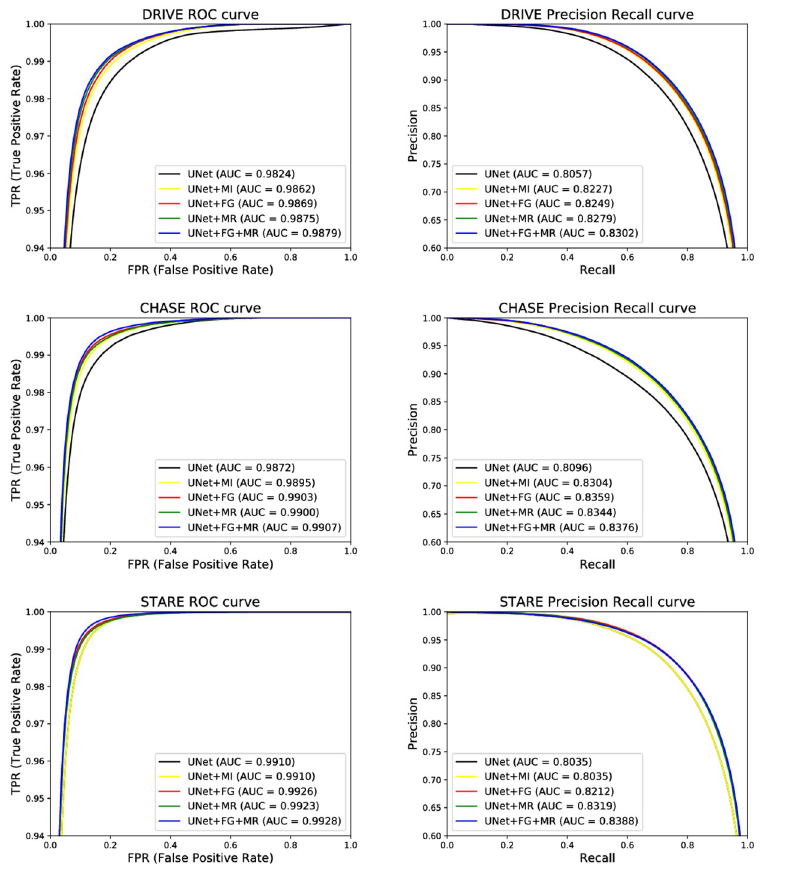
Fig 5. PR and ROC curves of each ablation structure.